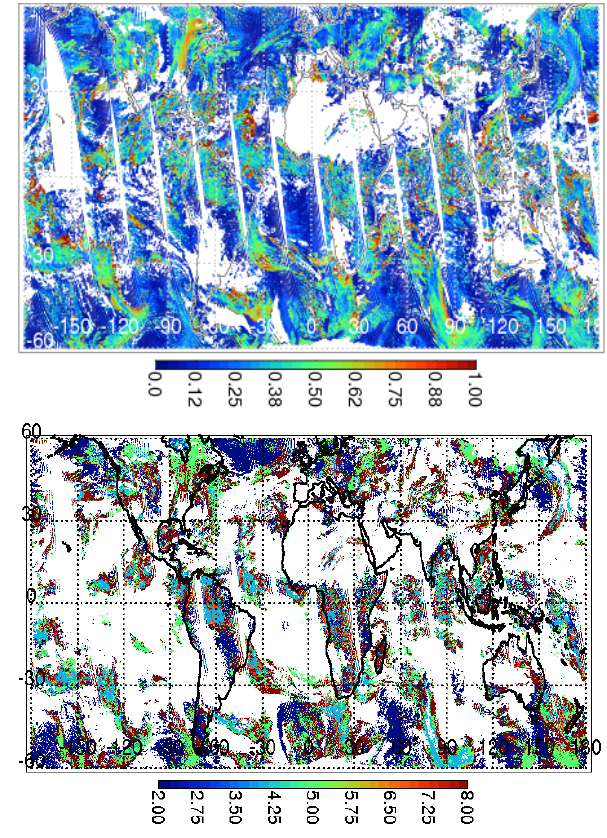
Fig. 2. As in Fig. 1 but showing fractional cloud pressure difference (OMI-MODIS), 1P diff (top) and MODIS maximum multi-layer flag (MLF) value within an OMI footprint (pixels where MLF ≥ 2,